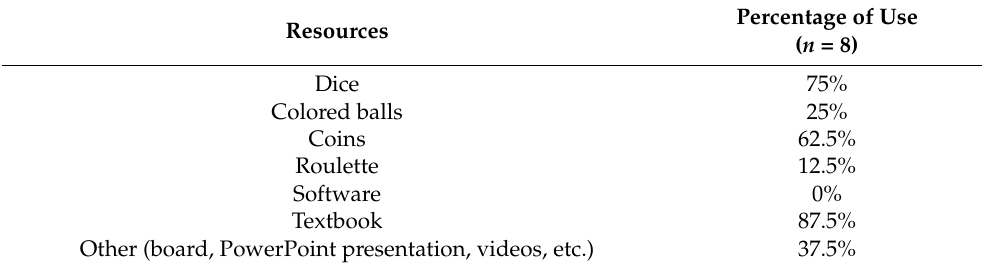
Table 4. Teaching and learning resources used.